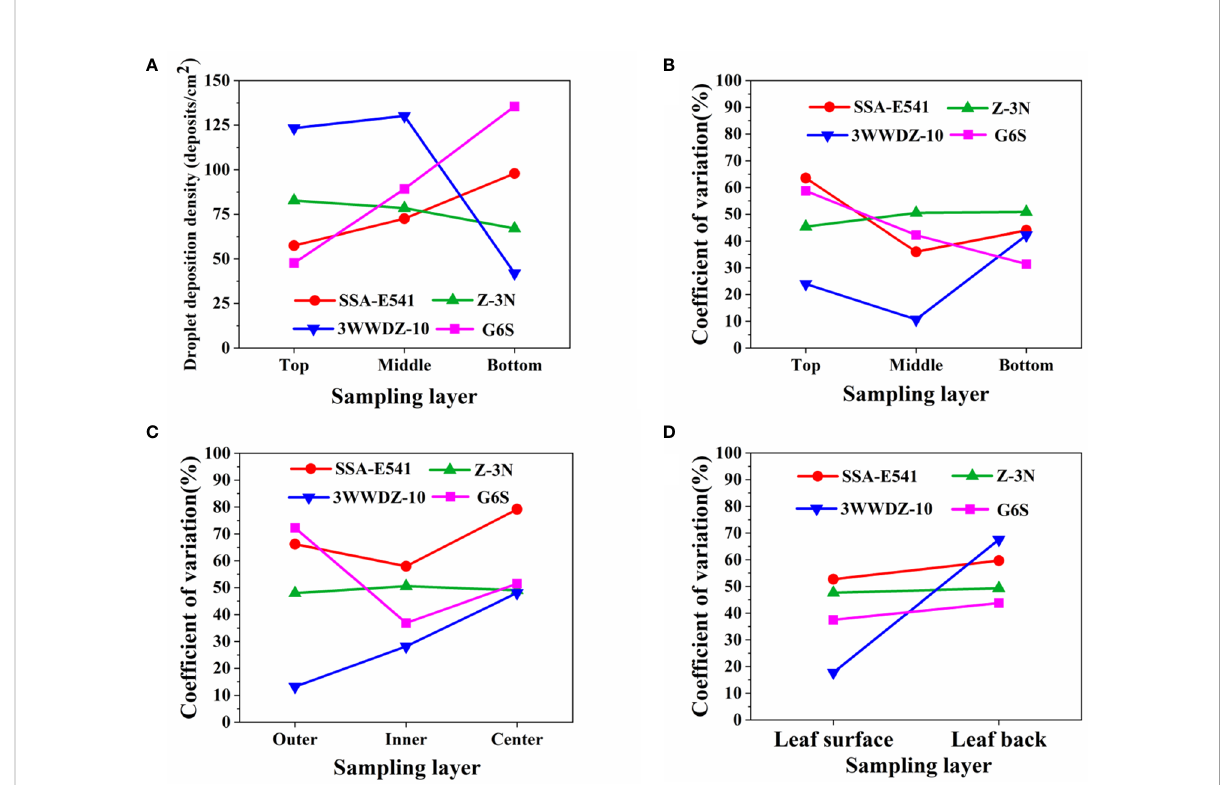
FIGURE 1 Typical equipment canopy droplet deposition experimental results. (A) Vertical longitudinal sampling layer droplet deposition density. (B) Vertical longitudinal sampling layer droplet distribution uniformity. (C) Horizontal radial sampling layer droplet distribution uniformity. (D) Uniformity of droplet distribution on leaf surface and leaf